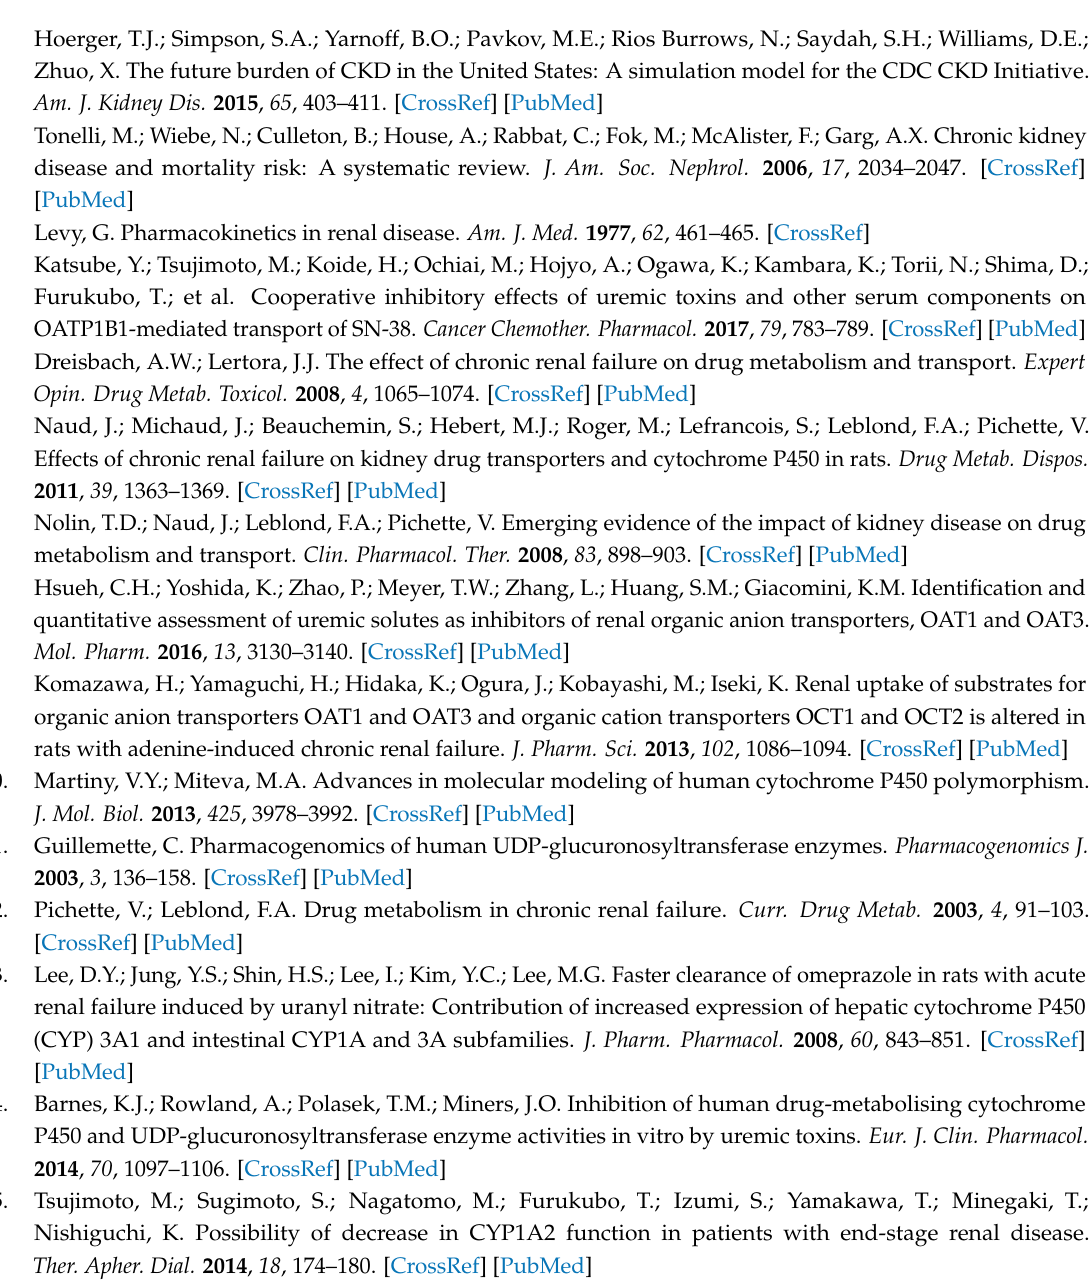
Figure S1: Impact of Renal Impairment on AUC in Females; Figure S2: Impact of Fraction Unbound on AUC in Females; Figure S3: Impact of Competitive Inhibition on AUC in